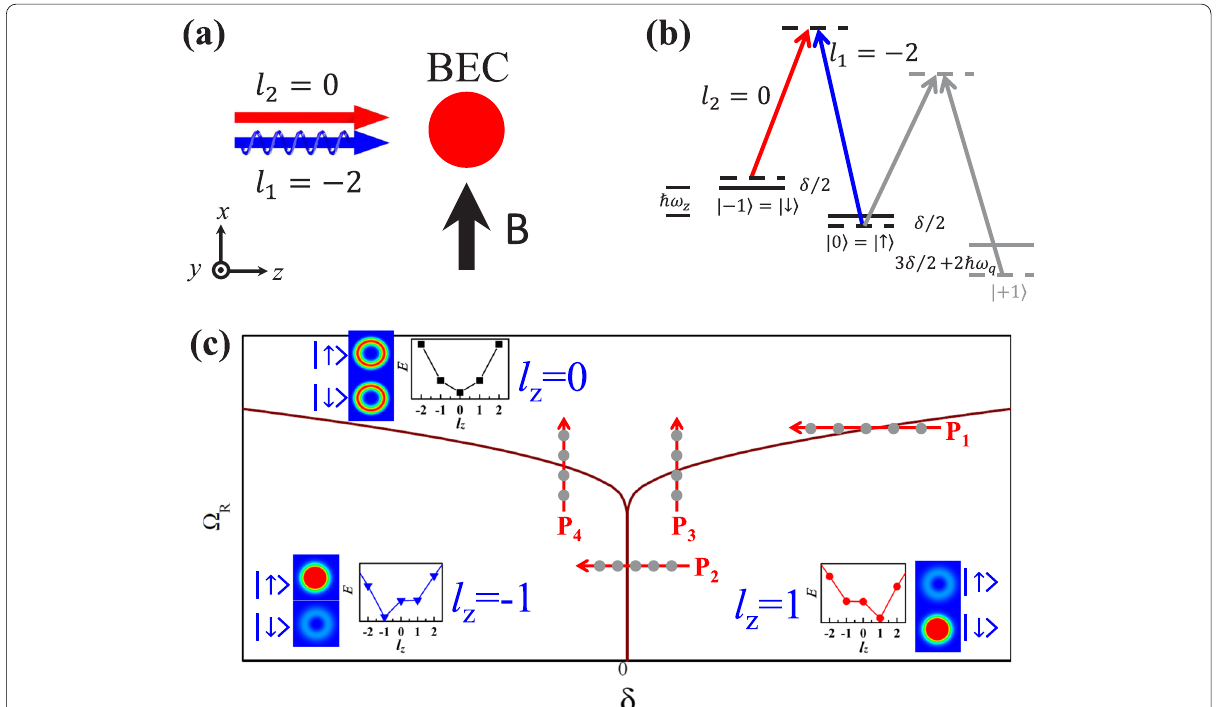
0 m F and | � = |↑� = 2 . The third = − 2 π 5.52 kHz. Here, δ is the two‑photon detuning. c The ≈ × 0, 1 . The corresponding lowest‑band = ±